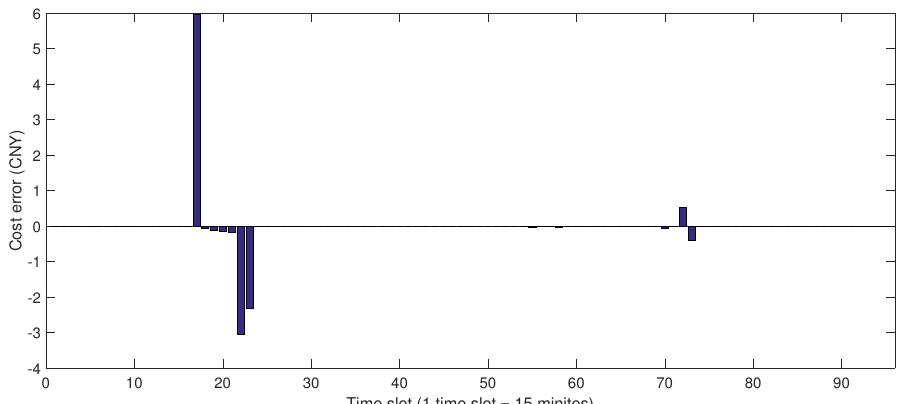
Figure 10. Errors between the operation cost of centralized optimization and distributed optimization. Table 3. Comparison of the operation cost by using the centralized and distributed optimization. MGs Centralized Optimization (CNY) Distributed Optimization (CNY) MG1 3211.63 3213.14 MG2 6754.12 6747.35 5515.76 5520.88 15,481.52 15,481.37